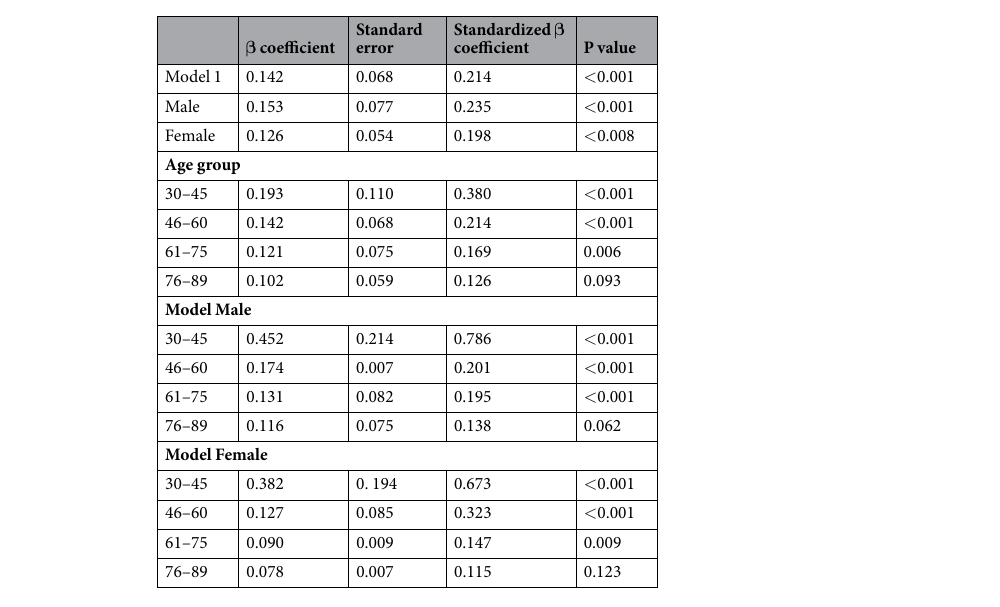
Table 5. Relationships between change in sleep quality and change in HbAlc in regression models. Model I = △ PSQI score vs △ HbAlc value, adjusted for age, educational level, family income, smoking, drinking, BMI, duration of diabetes, and presence of anxiety and depressive symptoms; Age group: adjusted for gender, educational level, family income, smoking, drinking, BMI, duration of diabetes, and presence of anxiety and depressive symptoms; Model Male = △ PSQI score vs △ HbAlc value in each age group of male adjusted for educational level, family income, smoking, drinking, BMI, duration of diabetes, and presence of anxiety and depressive symptoms; Model Female = △ PSQI score vs △ HbAlc value in each age group of female, adjusted for educational level, family income, smoking, drinking, BMI, duration of diabetes, and presence of anxiety and depressive symptoms. 1520 Registered people with type 2 diabetes in selected